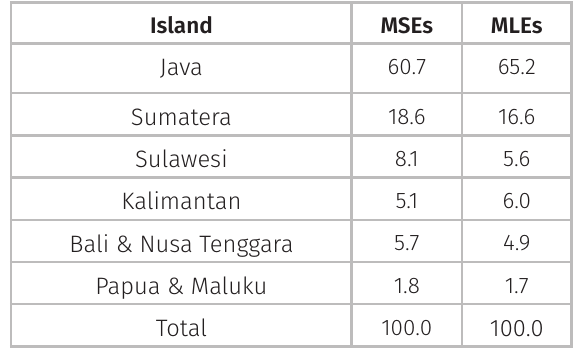
Table II. Distribution of MSEs and MLEs by island, 2016 (%).